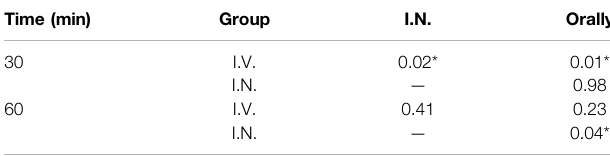
TABLE 2 | Comparison of surgical fi eld